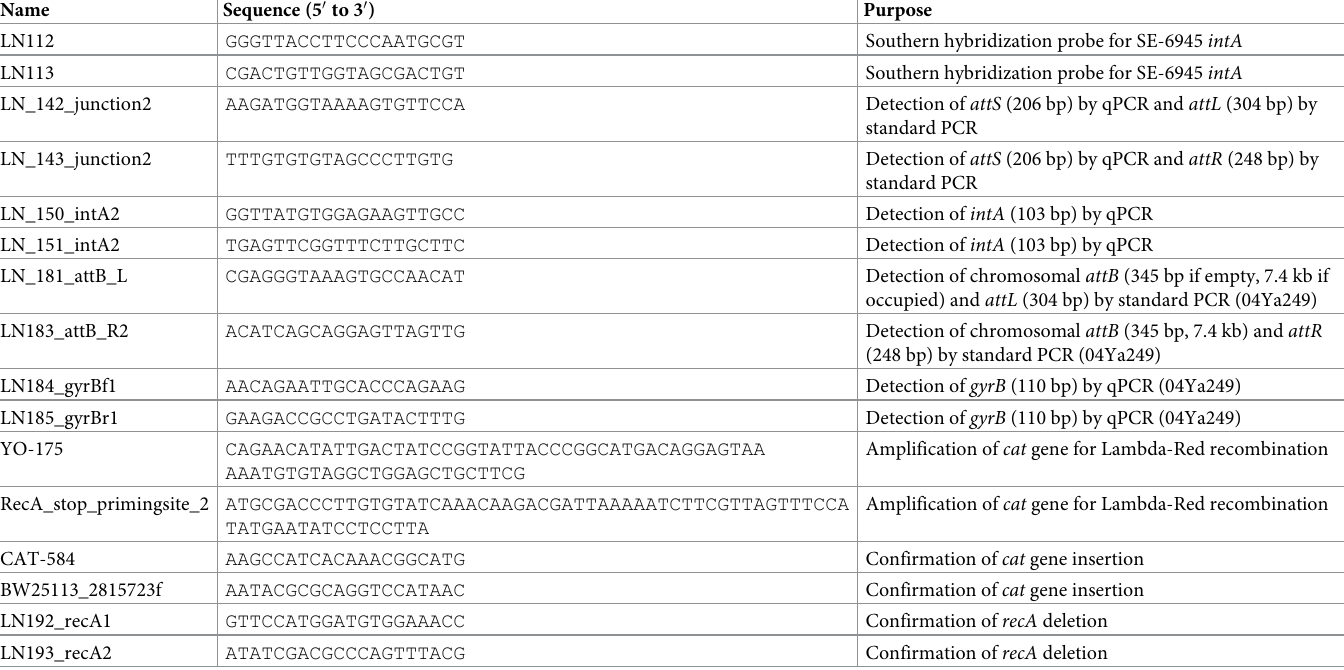
Table 2. Oligonucleotides